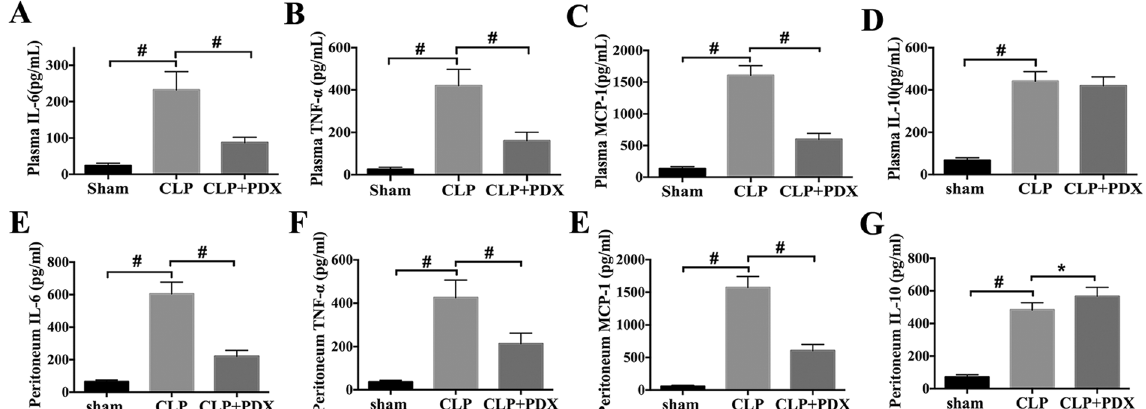
Figure 4. PDX attenuated inflammatory response locally and systemically in sepsis. Plasma and peritoneal lavage fluid (PLF) were harvested 24 hours after CLP. Pro-inflammatory cytokines TNF-a ( A , E ), IL-6 ( B , F ) and MCP-1 ( C , G ) and anti-inflammatory cytokine IL-10 ( D , I ) in plasma and PLF were performed by ELISA analysis. Data are presented as mean ± SEM (n = 6). # P < 0.01.